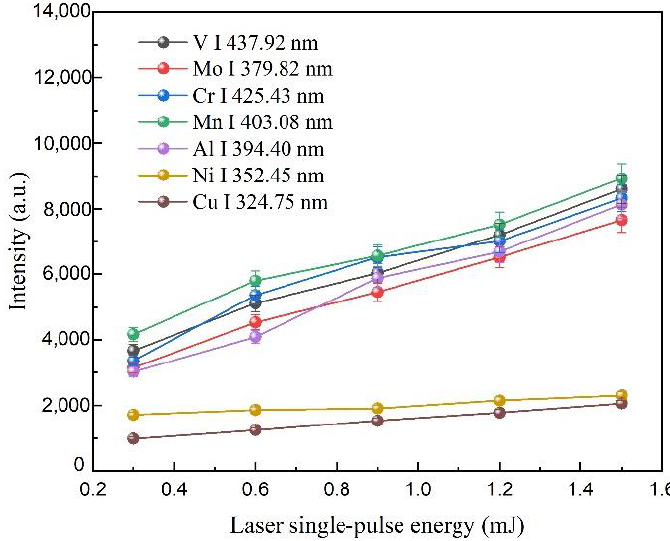
Figure 5. Plots of V, Mo, Cr, Mn, Al, Ni, and Cu elements spectrum signal intensities observed in fs LA-SIBS under different laser single-pulse energy.